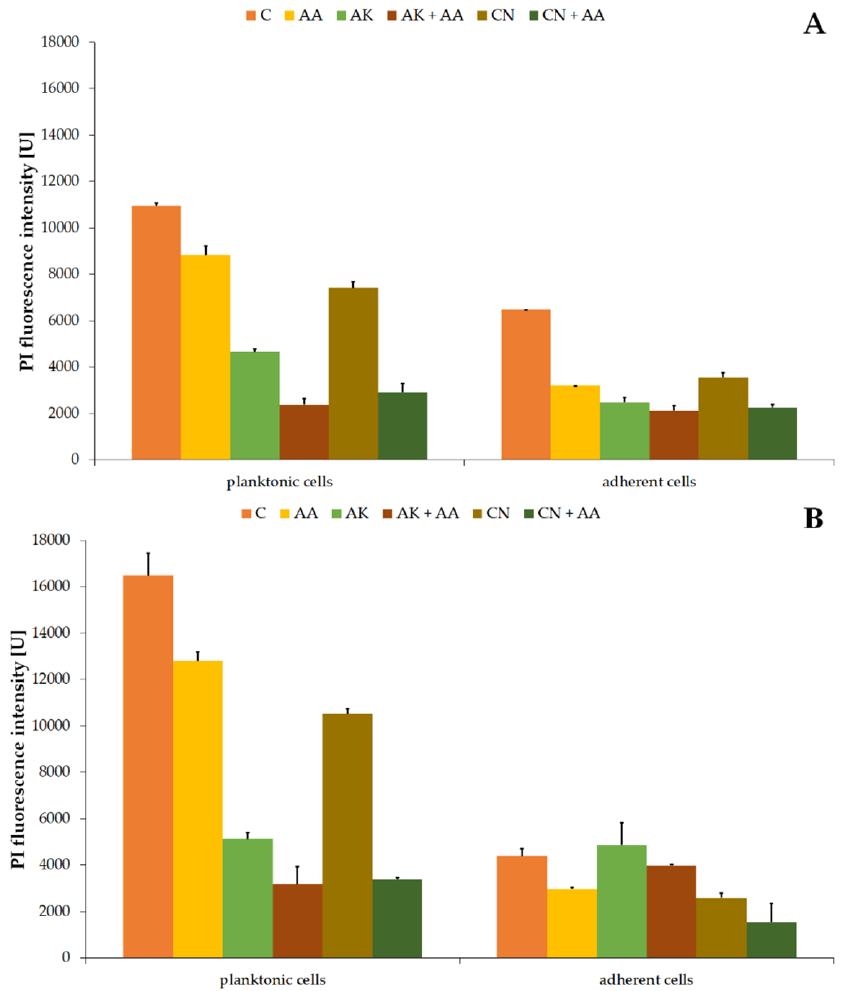
Figure 6. Changes of propidium iodide (PI) fluorescence intensity in the planktonic and adherent cells of the ATCC 29906 ( A ) and C12 ( B ) strains treated with AA, AK, or CN. Legend: C—control, AA—ascorbic acid, AK—amikacin, CN—gentamicin. PI fluorescence intensity values in non-treated planktonic cells were 10,953.94 U ± 111.75 U (Figure 6A) and 16,486.57 U ± 952.23 U (Figure 6B) for the ATCC 29906 and C12 strains, respectively. Applied therapies resulted in significantly weakened red fluorescence. Mem- brane permeability for propidium iodide decreased by at least 20%, 60%, and 30% in the AA-, AK-, and CN-treated cells, respectively. Moreover, the combined activity of AA and the aminoglycosides lowered the PI fluorescence intensity even more (by 40% and 60%) than AK and CN monotherapies,